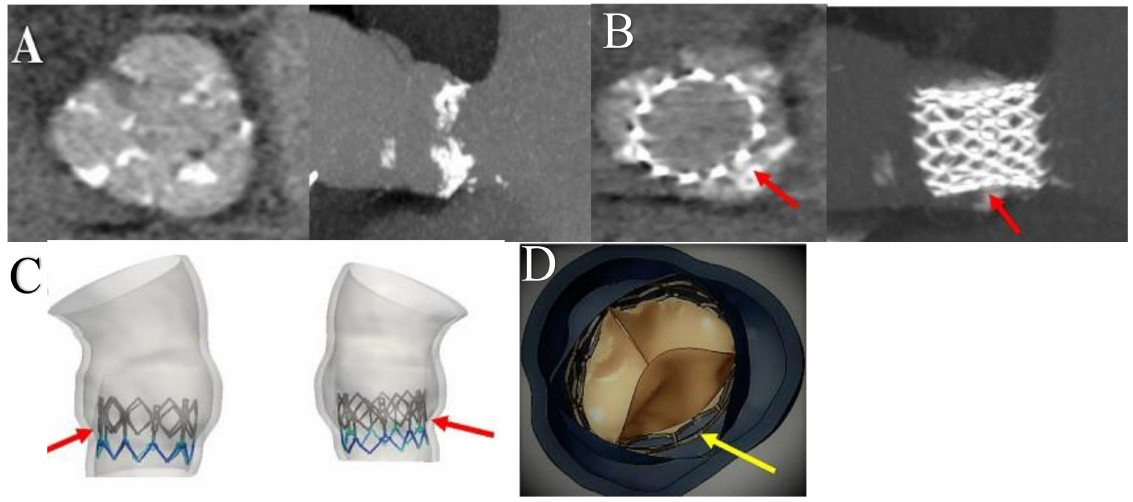
Figure 8. Depict preoperative ( A ) and postoperative ( B ) 3 D CT scan with TAVI thrombosis. ( C ) Bio- modelling of a Sapien XT reveals an incomplete deployment (red arrow) of the device with PAVR and thrombotic formation (red arrow). ( D ) The yellow arrow disclose a distortion of the stent and reduced mobility of the leaflet of the bioprosthesis in correspondence of the PAVR. Abbreviations; PAVR paravalvular aortic regurgitation. Other abbreviations in previous